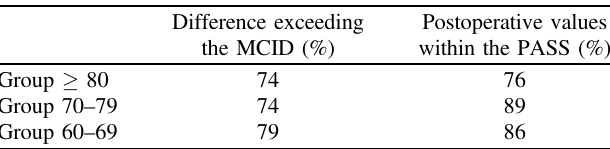
Figure 1. Box plot WOMAC. Table 7. Results of the WOMAC score compared to PASS and